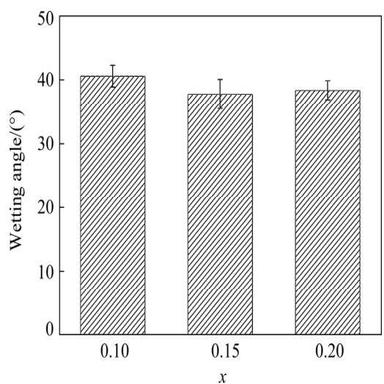
etting angle of (Sn1−xZnx)57(In0.78Bi0.22)43 solder alloys